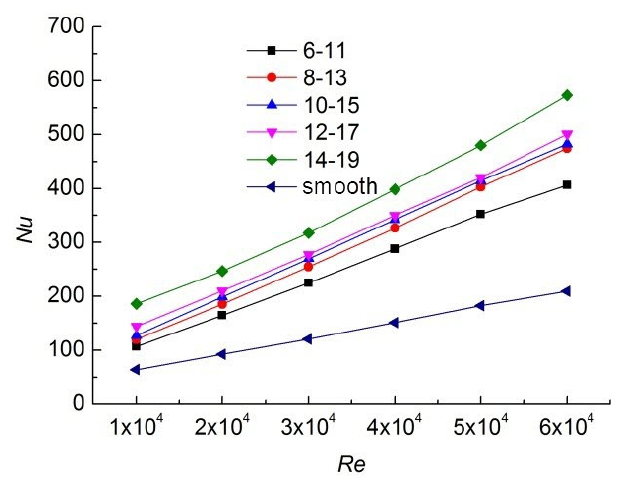
Figure 6. Variation of Nusselt number in tube with Re.